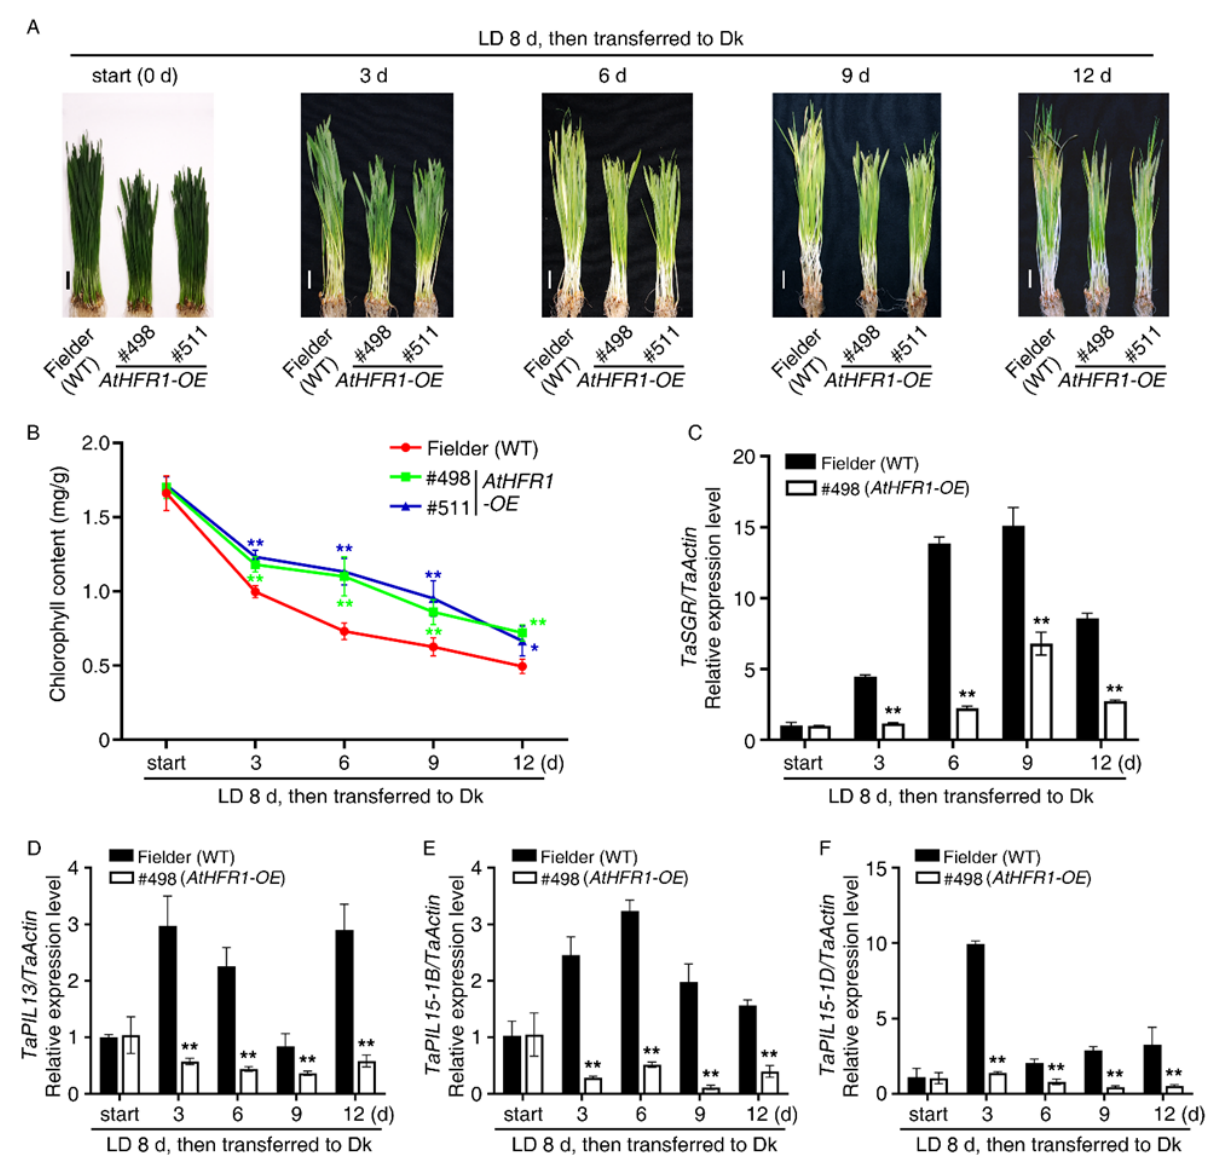
Figure 6. The AtHFR1 transgene promotes wheat resistance to dark-induced senescence: ( A ) Morphology of the WT (cv. Fielder) and AtHFR1 transgenic lines (#498 and #511) treated with light starvation. Seedlings were grown under long-day conditions for 8 days, and then transferred to the dark for 0, 3, 6, 9, or 12 days. Bars = 2 cm. ( B ) Chlorophyll contents corresponding to ( A ). Mean and SD ( n ≥ 5) are shown. Real-time RT-PCR analysis of TaSGR ( C ), TaPIL13 ( D ), TaPIL15-1B ( E ), and TaPIL15-1D ( F ). Data are means ± SDs, n = 3. Asterisks denote significant differences in #498 or #511 with the WT according to ANOVA (* p < 0.05, ** p < 0.01). See also Figure